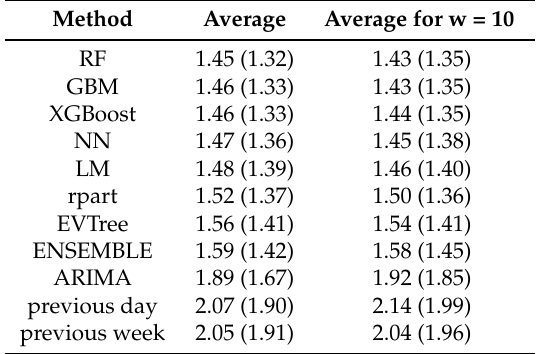
Table 5. Average RMSE obtained by the methods for all the values of historical window and on all the buildings.The standard deviation is shown in brackets.